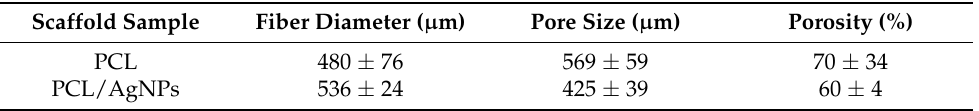
Figure 9. SEM images of fabricated scaffold from top-view: ( a ) PCL and ( b ) PCL/AgNPs. Side-view: ( c ) PCL and ( d ) PCL/AgNPs. Table 3. Summary of average fiber diameter and pore size of PCL and PCL/AgNPs scaffolds based on SEM and porosity based on the Archimedes Law (n = 3).